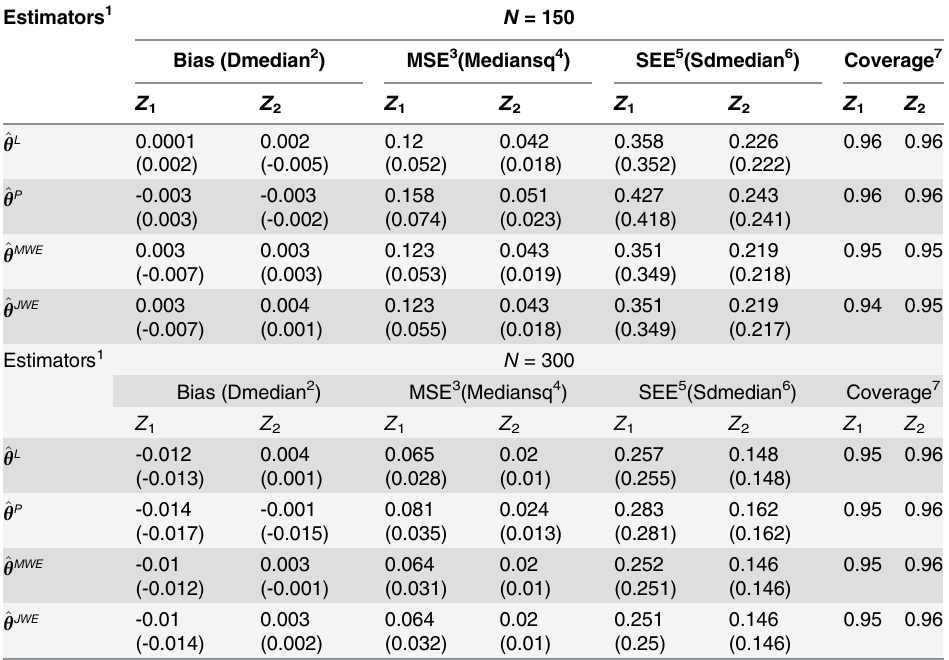
Table 3. Simulation result when N = 150 and N = 300, σ 2 = 0 with two covariates (Z 1 : U(0, 1), Z 2 : Ber- noulli(0.5)). Estimators 1 N = 150